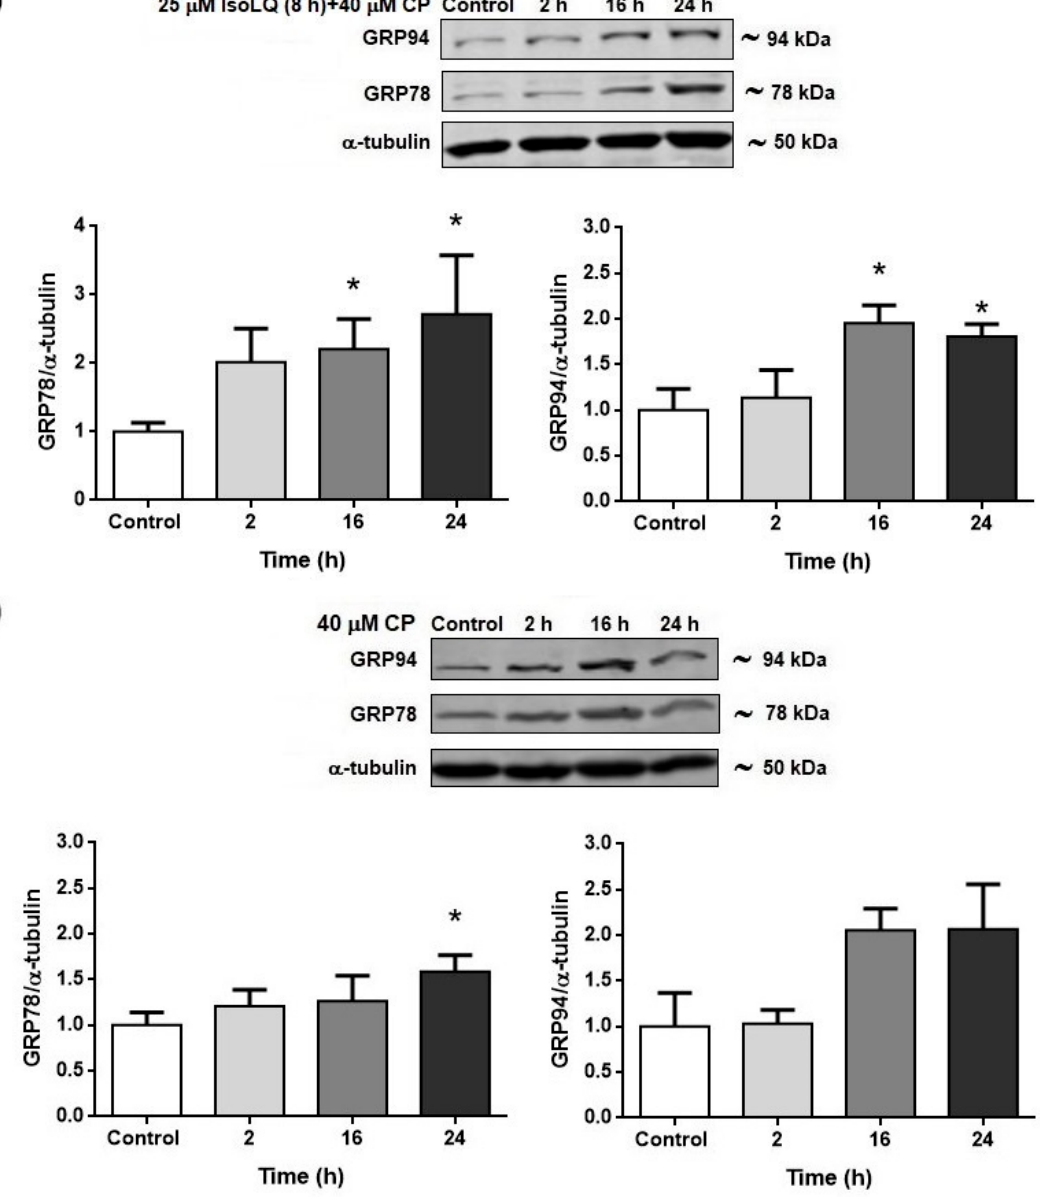
Figure 6. Endoplasmic reticulum (ER) stress in LLC-PK1 cells. ( A ) 25 μ M isoliquiritigenin (IsoLQ, 8 h) pretreatment + 40 μ M cisplatin (CP) treatment. ( B ) 40 μ M CP treatment. Glucose-related protein